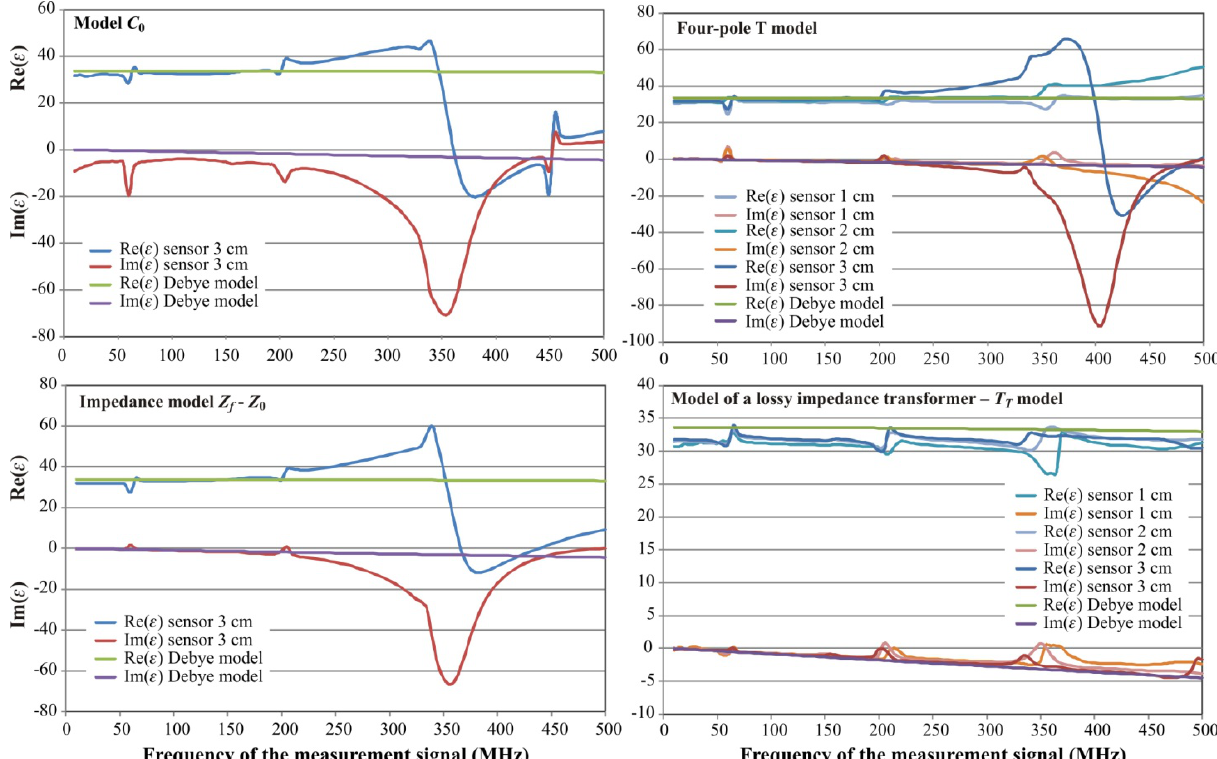
Figure 9. Performance comparison of the analyzed FDR sensor models for methanol as the verification